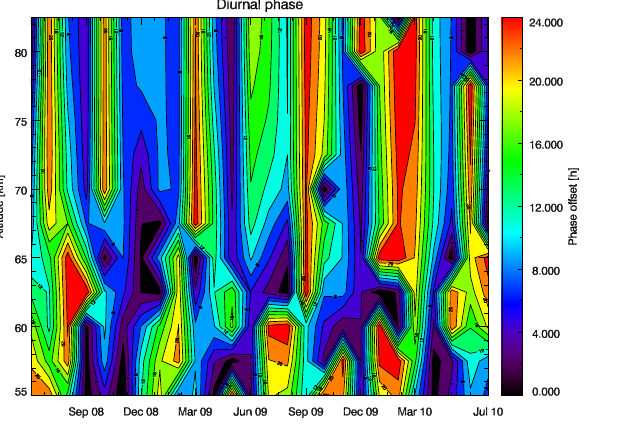
Fig. 5. The same state of affairs as Fig. 3, but showing the phase. Fig. 6. As Fig. 4, but showing the